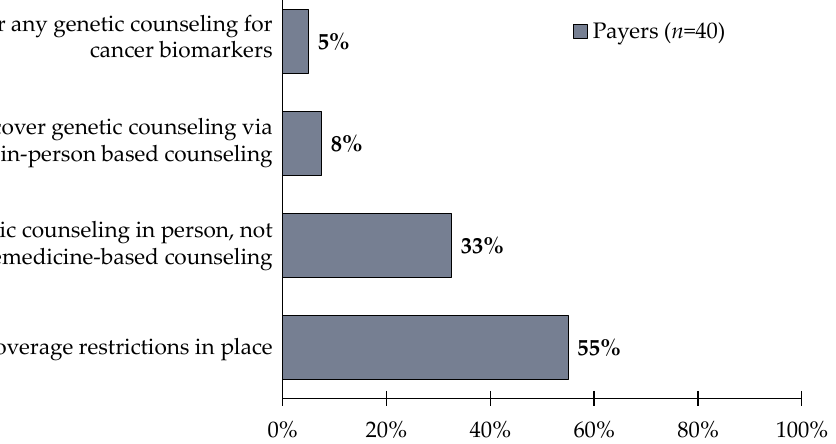
Figure 5. Payers ( n = 40) were asked the following questions: Which of the following best describes your plan’s coverage of genetic counseling to support biomarker test ordering and results reporting? 55% of respondents reported having no coverage restrictions in place, but notably 33% of respondents report not covering telemedicine-based genetic counseling.